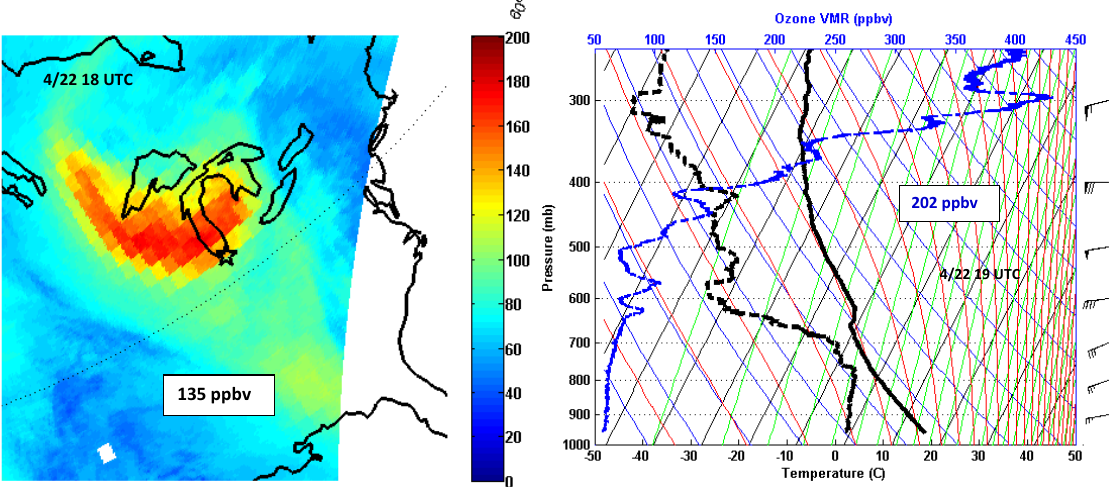
Fig. 7. (a) . The zoomed MUTOP image from 18:00UTC, 22 April shows the location of the Valparaiso ozonesonde site (black star) on the edge of the advancing upper level cutoff low over the Great Lakes region, at the base of the cut-off low and in the vicinity of strong vertical wind shear. The color bar represents estimated layer-average UT ozone VMR inppbv, and indicates MUTOP at 18:00UTC was 135ppbv. (b) The ozonesonde Skew-T plot is from 19:00UTC, 22 April 2006 and displays c temperature (black solid), dew point (black dashed) and ozone VMR (blue dashed). Note the extremely enhanced ozone captured by the sonde between 500–300hPa, the layer-average ozone was